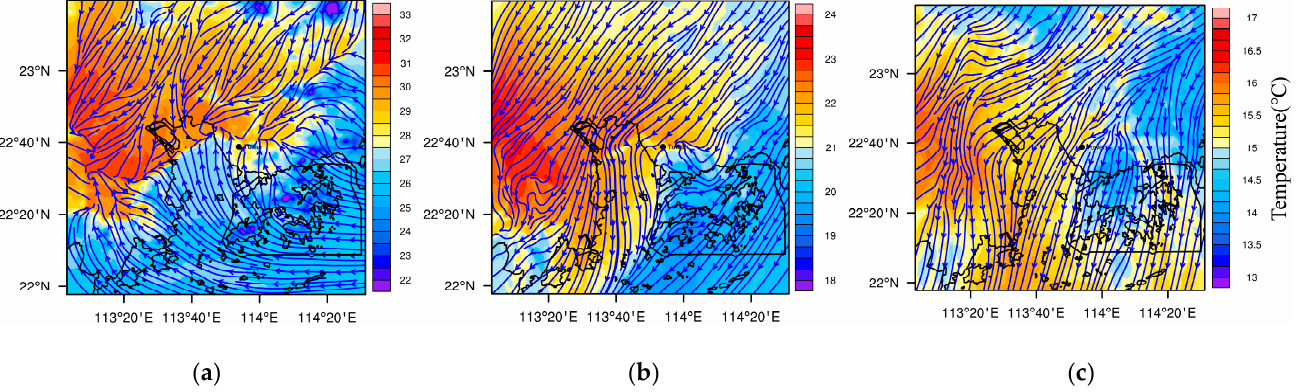
Figure 5. The wind streamlines and temperature field at 18:00 from the WRF model. ( a ) surface; ( b ) at 925 hPa; ( c ) at 850 hPa. The black dot represents the observation site. Figure 6 shows the evolution of wind streamlines and temperature near the surface after the sea breeze arrived. At 19:00, the sea breeze from the Pearl River Estuary continued to control the observation site and pushed inland. At 20:00, the second sea breeze arrived at the observation site via the northeast side of Hong Kong. The complex underlying surface of land might slow down the advancing speed of the sea breeze, so the arrival time was late. The distance of this sea breeze intruding inland can reach 60 km.